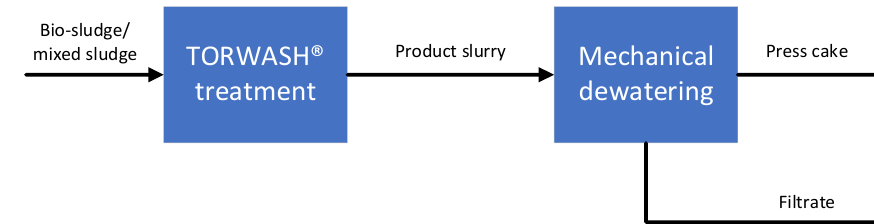
Figure 1. Schematic representation of the TORWASH ® process.